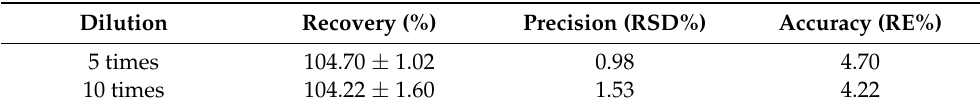
Table 4. Dilution integrity developed HPLC method for RB (means ± SD, n =